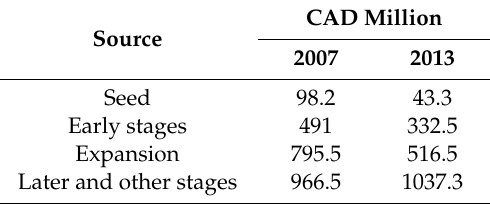
Table A4. Venture and growth capital in Canada,